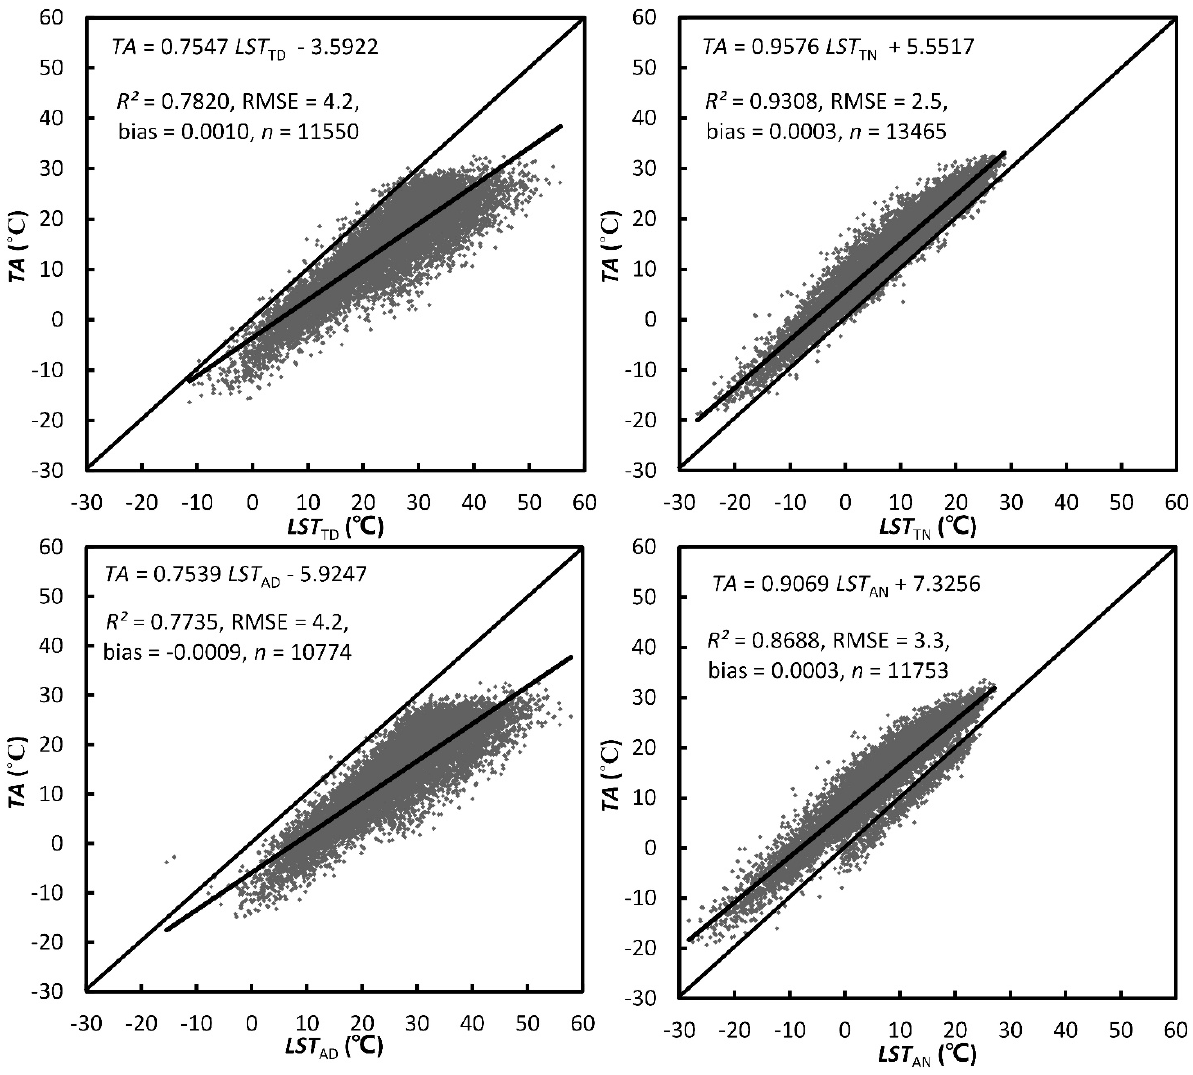
Figure 2. The relationship between observed TA at the 23 meteorological stations and the daytime and nighttime MODIS LSTs (2003 to 2011). The diagonal line from the origin represents the relationship TA = LST ; the shorter lines represent the linear regression